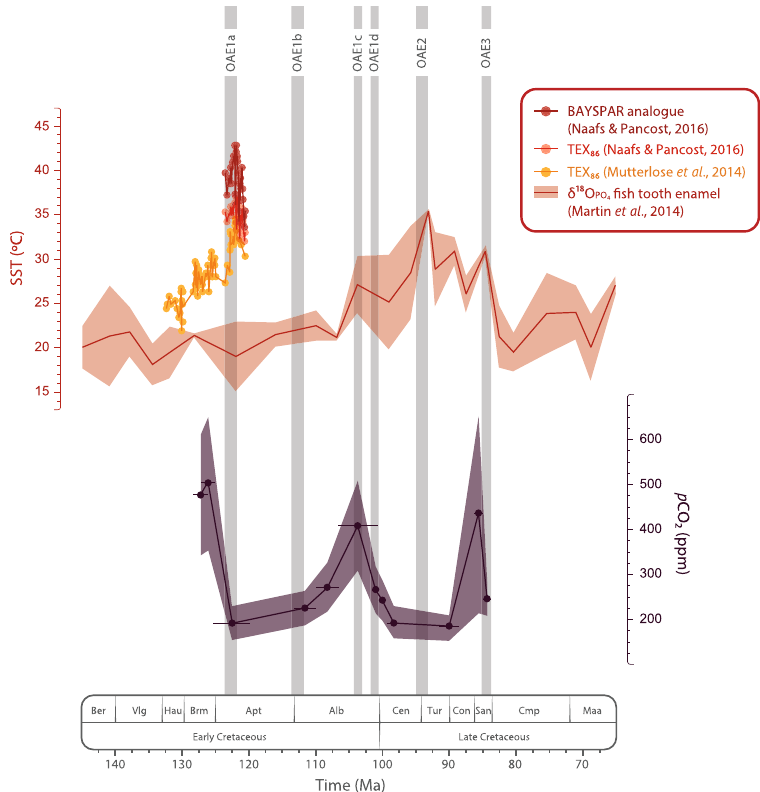
Figure 3. Reconstructed p CO 2 compared with available sea surface temperature (SST) records 11–13 for the Cretaceous. Vertical grey bars represent major Oceanic Anoxic Events (OAE) occurring during the Cretaceous 18 . Envelopes represent ± 1 σ